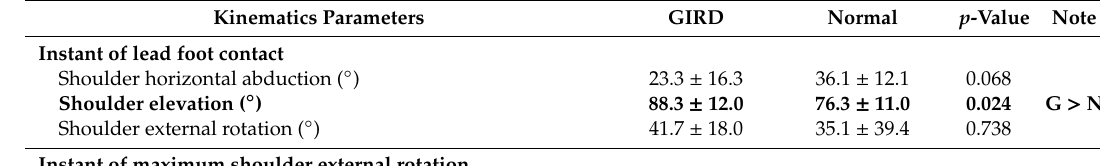
Table 2. Comparison of kinematic parameters in GIRD and Normal